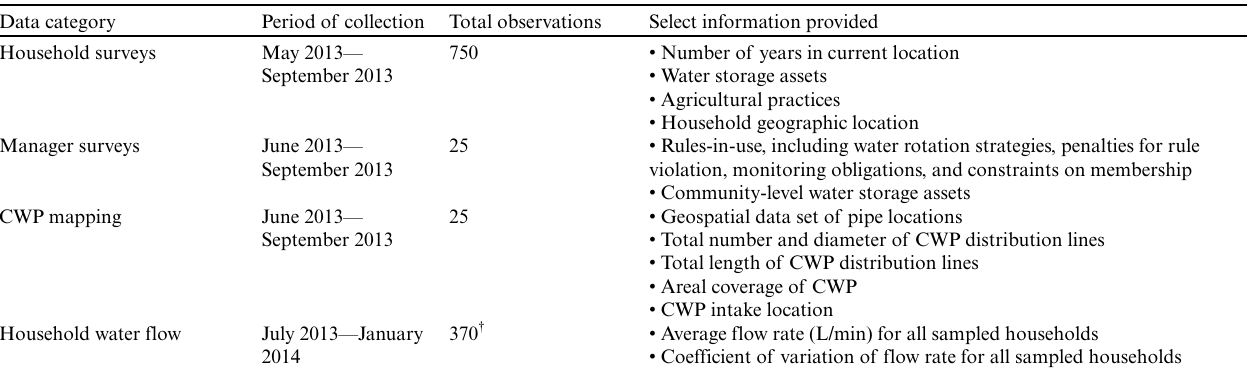
Table 3. Data collection